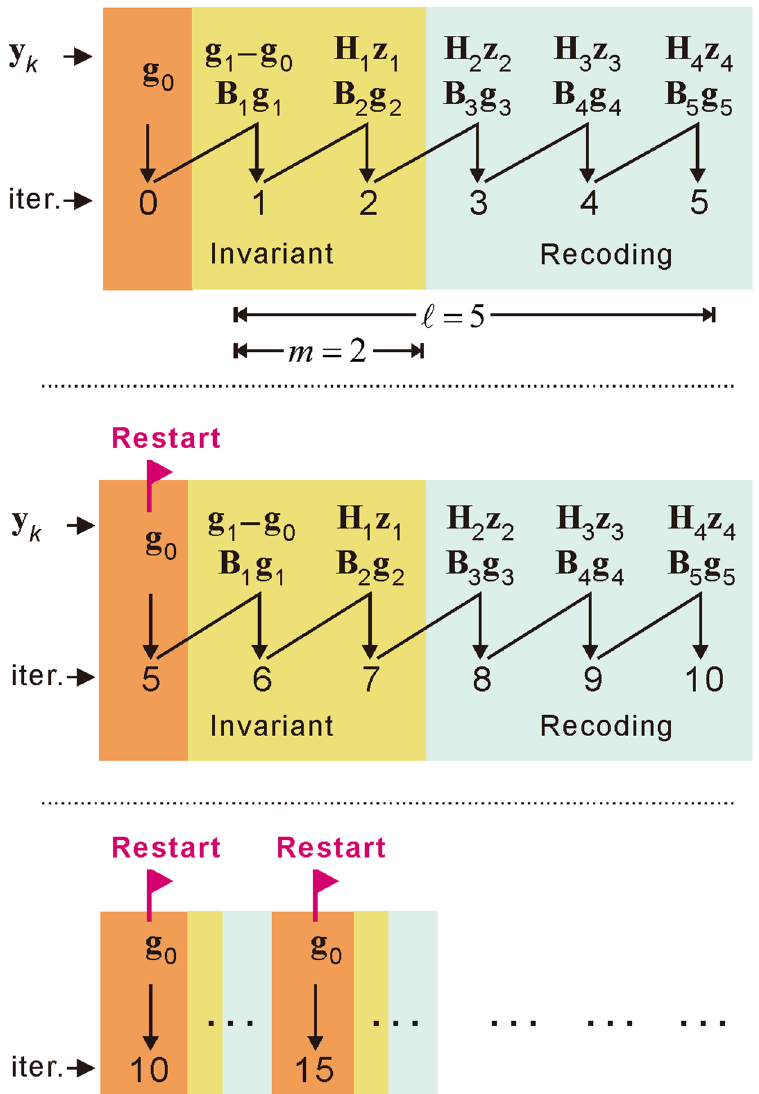
Figure 1. The restarted L-BFGS algorithm. The implementation of the L-BFGS algorithm is restarted after a number of iterations (  ). Within the segment between two starts, only the coding of the first few iterations ( m ) is kept unchanged (yellow) and is the same as the previous one (orange). The shots for the rest of the iterations (grey) are re-coded with a sufficient randomness to suppress crosstalk effects. Within a restarted segment, the gradient differential is given by the secant equation y k − 1 = H k − 1 z k − 1 except for the first iteration, where y 0 = g 1 − g 0 . Both H k − 1 z k − 1 and B k g k are calculated using the limited-memory